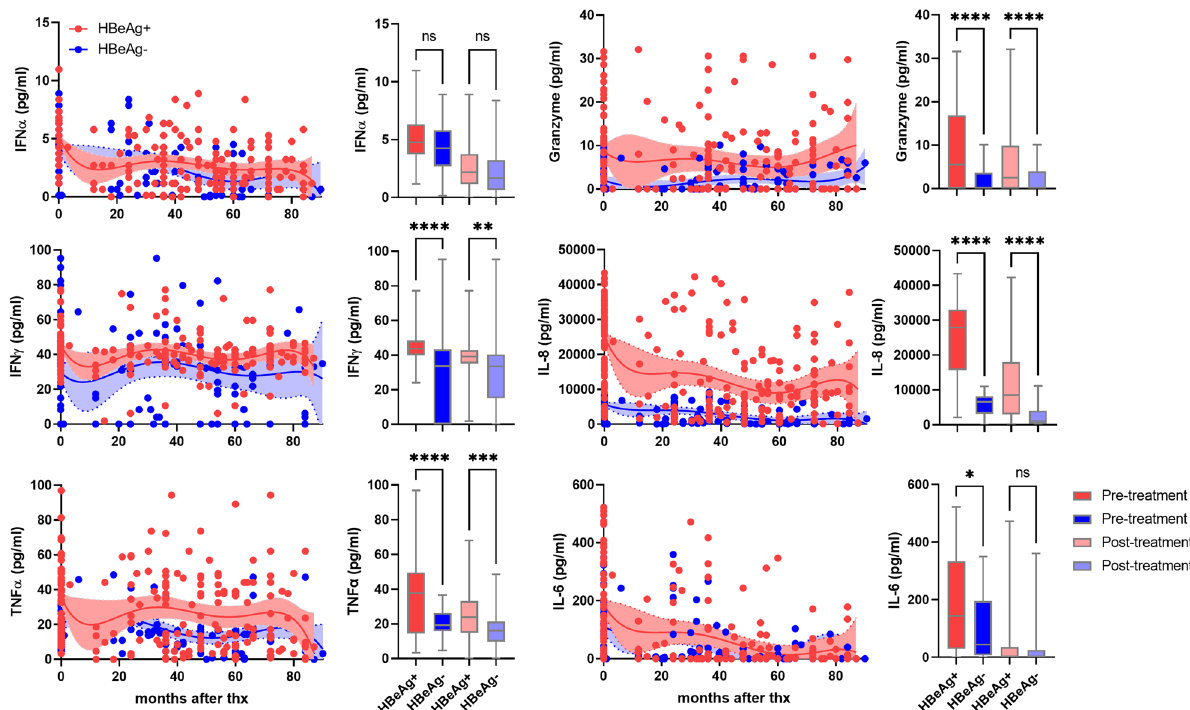
Figure 5. Cytokine levels in HBeAg-positive patients and HBeAg-negative patients. Circulating IFNα, IFNγ, TNFα, granzyme, IL-8, and IL-6 levels in HBeAg-positive patients (red dots) and HBeAg-negative patients (blue dots). Shaded areas indicate 95% confidence intervals around the regression lines. Bar graphs represent concentration of each cytokine in pre-treatment (dark red), post-treatment (light red) of HBeAg-positive and pre-treatment (dark blue), post-treatment (light blue) of HBeAg-negative patients. *p ≤ 0.05, **p ≤ 0.01, ***p ≤ 0.001, ****p ≤